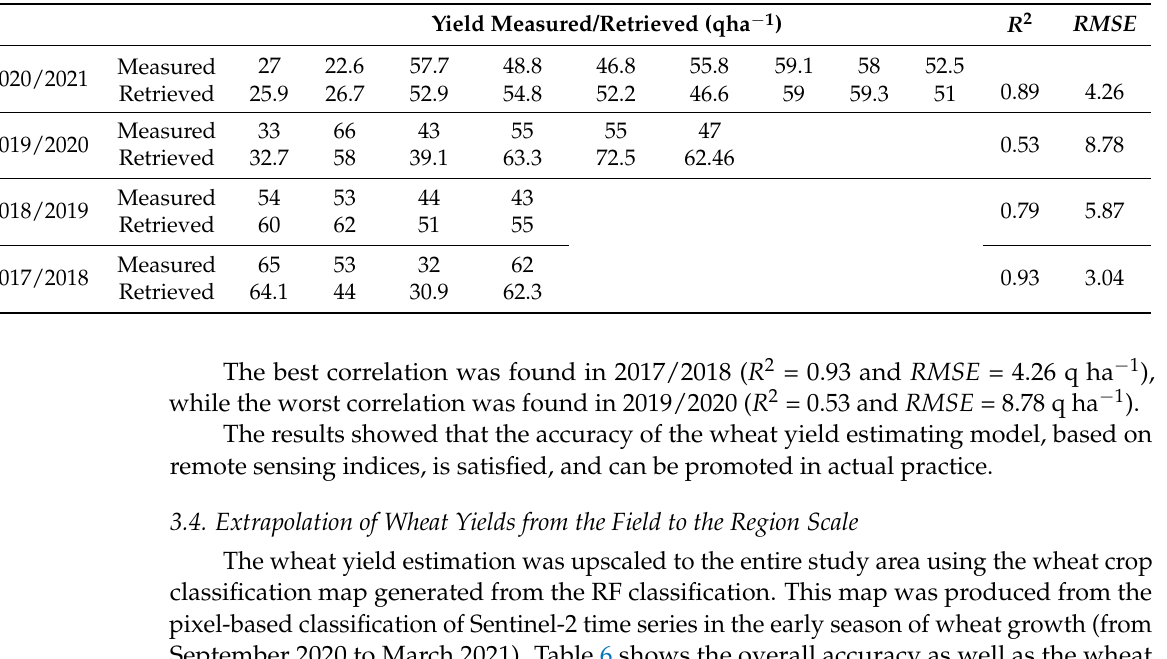
Table 5. The comparison of wheat yield in situ measured and retrieved from remote sensing